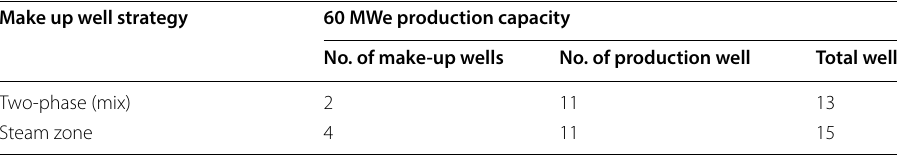
Table 7 Total wells needed for 60 MW of 30 years production Make up well strategy 60 MWe production capacity No. of make-up